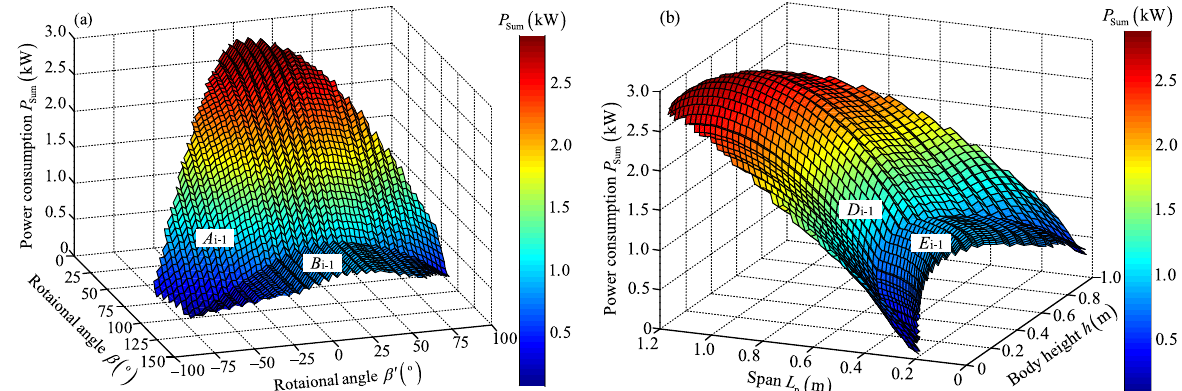
Figure 8 Variable tendency charts of P sum under secondary working conditions i-1: (a) With changes in β ′ and β , (b) with changes in h and L p